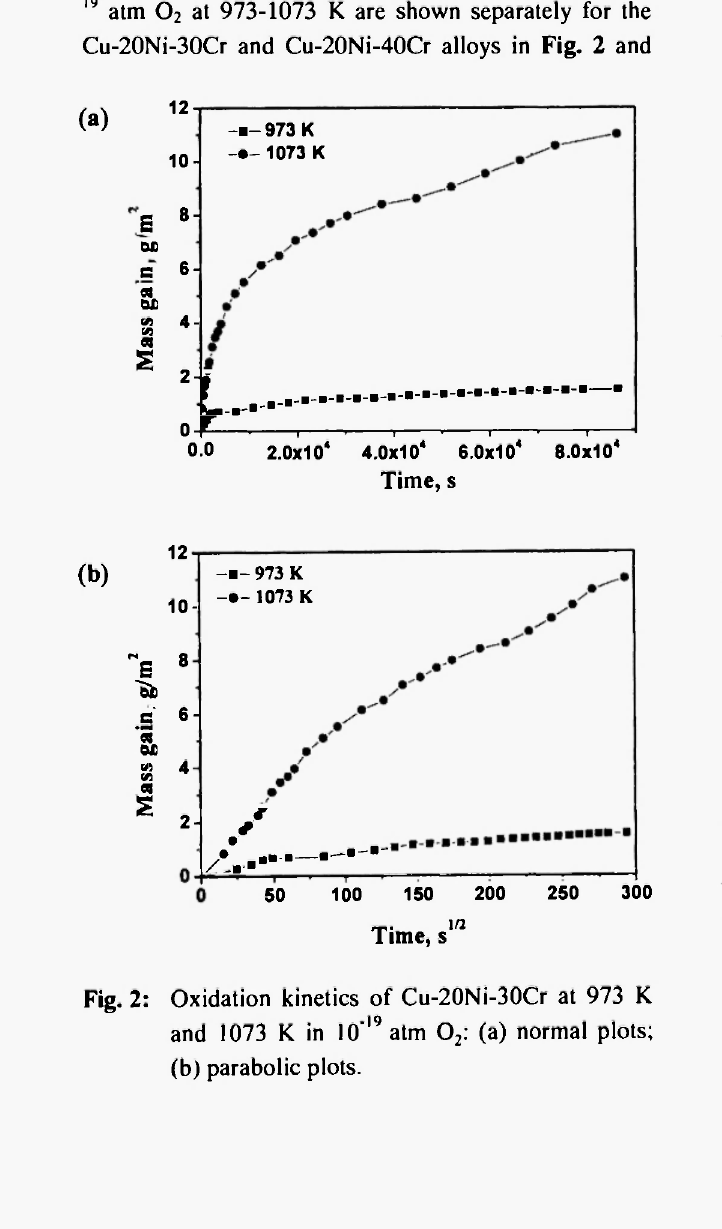
Fig. 3: Oxidation kinetics of Cu-20Ni-40Cr at 973 Κ and 1073 Κ in I0"' 9 atm 0 2 : (a) normal plot; (b) parabolic plots.